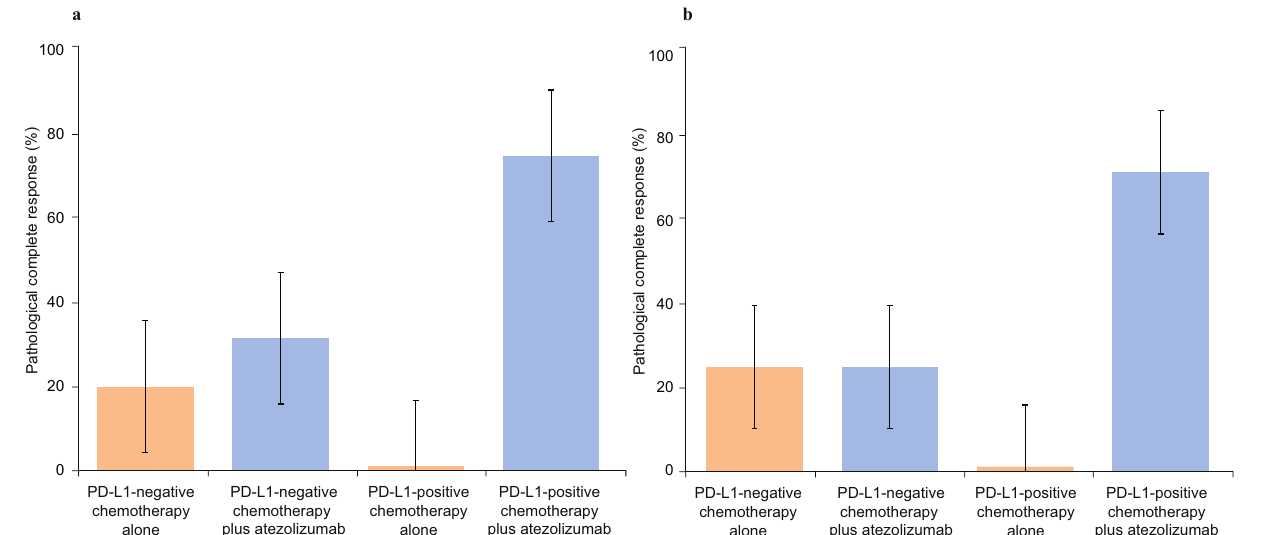
Fig. 5 Pathological complete response by PD-L1 status. a PD-L1 status assessed by VENTANA PD-L1 (SP142) assay in patients treated with chemotherapy alone and chemotherapy plus atezolizumab. Orange areas represent Arm A chemotherapy only. Blue areas represent Arm B chemotherapy plus atezolizumab. b PD-L1 status assessed by multiplex immuno fl uorescence in patients treated with chemotherapy alone and chemotherapy plus atezolizumab. PD-L1-positive status represents the percent positive cells on in fl ammatory cells (PD-L1-positive cytokeratin-negative or CD8-positive cells), divided by the total number of cytokeratin-negative and CD8 positive cells. Orange areas represent Arm A chemotherapy only. Blue areas represent Arm B chemotherapy plus atezolizumab. Error bars represent standard error of pCR